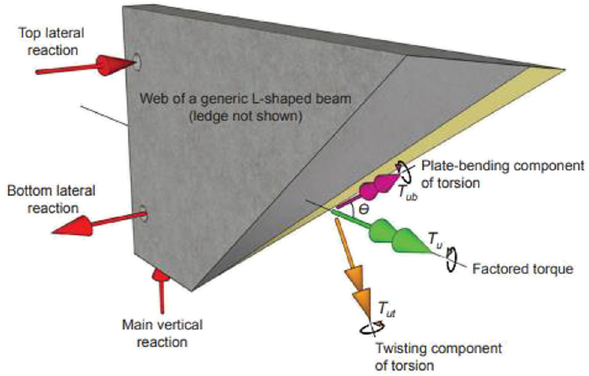
Figure 2: Torsion components on a cross - section [ 13 ]